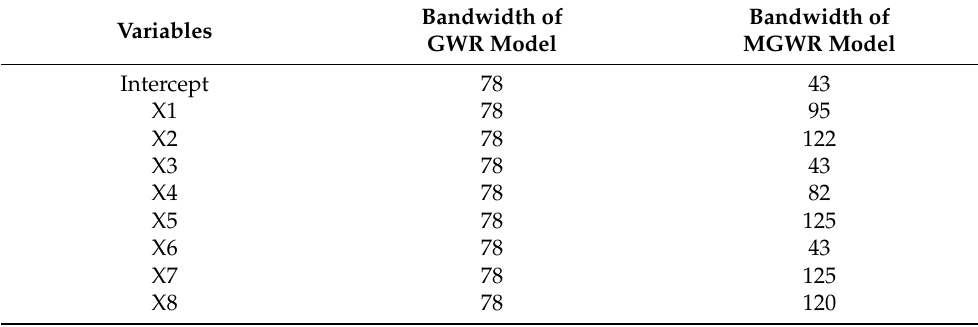
Table 4. Bandwidth comparison between GWR and